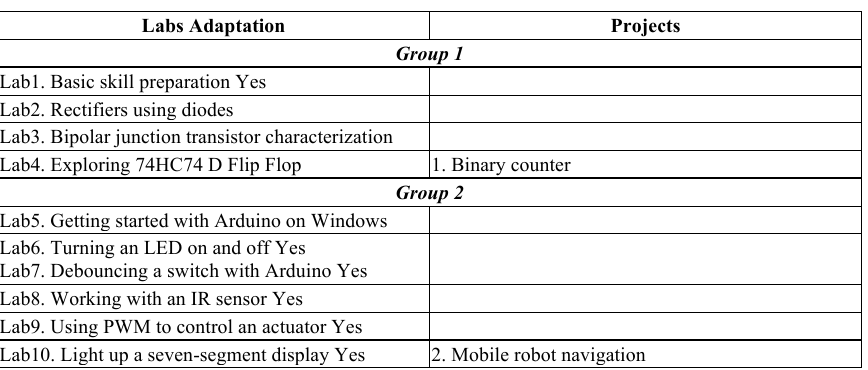
Table 2. List of hands-on